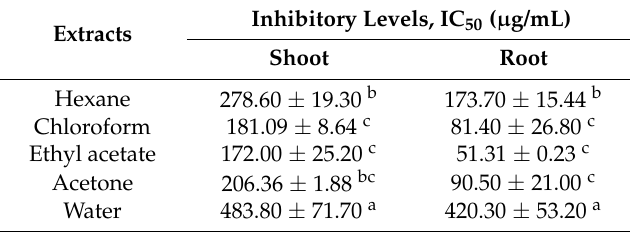
Table 2. Effect of P. methysticum root extracts on growth of R. sativus (IC 50 values).